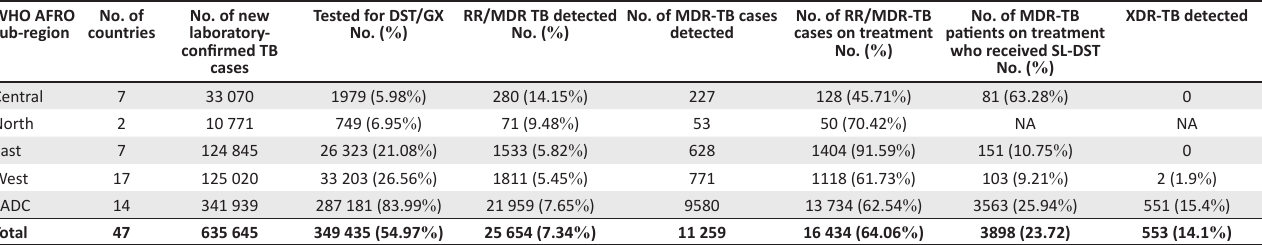
TABLE 4: Regional distribution of first- and second-line tuberculosis drug susceptibility tests performed for notified cases reported in 2015 in Africa. WHO AFRO No. of sub-region